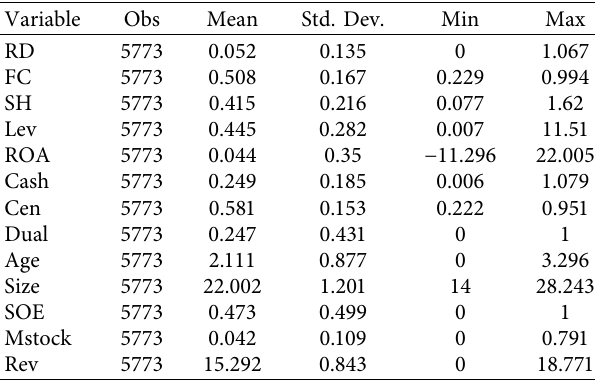
Table 2: Descriptive statistics of